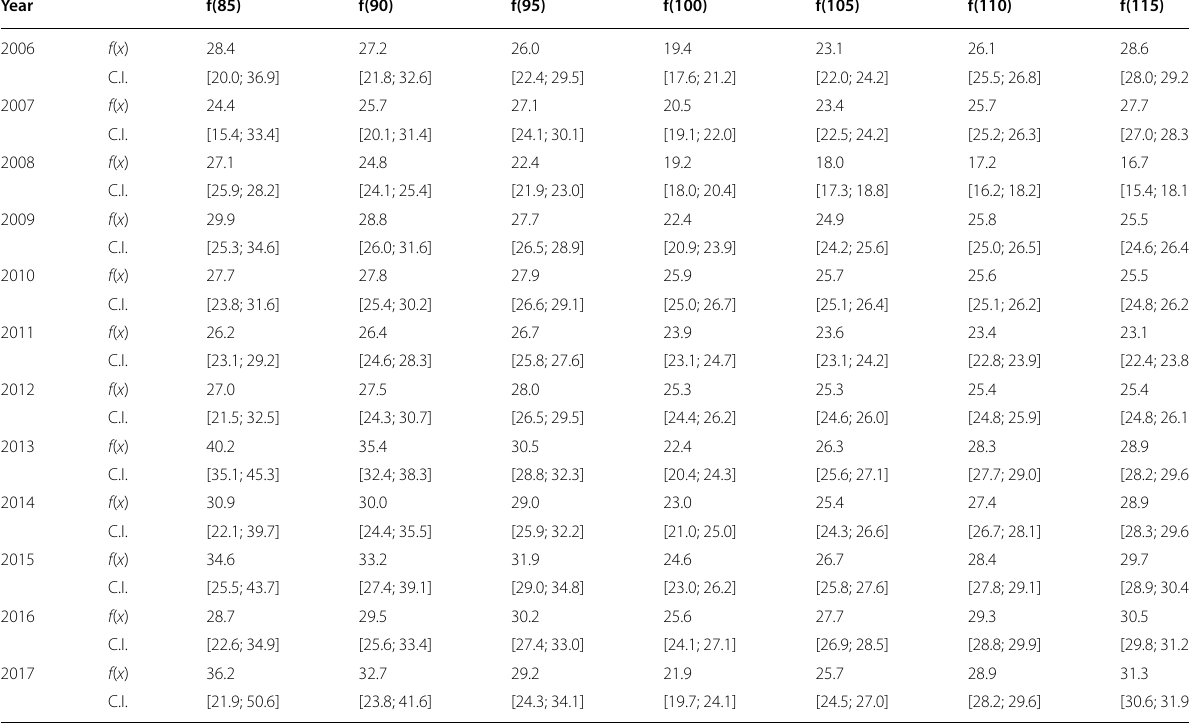
Point estimates ( f ( x )) for local average share of assets invested in equities (in percent), for different funding ratios (in percent). Estimates from global polynomial regression with separate number of polynomials for funds with a funding ratio of below, and above 100%, respectively. Confidence band (C.I.) in square brackets is from bootstrapped standard errors (500 iterations). The sample includes only private and public funds without state guarantees, and includes only funds with a funding ratio between 81.5 and 152.3% (0.5th–95th percentile range)